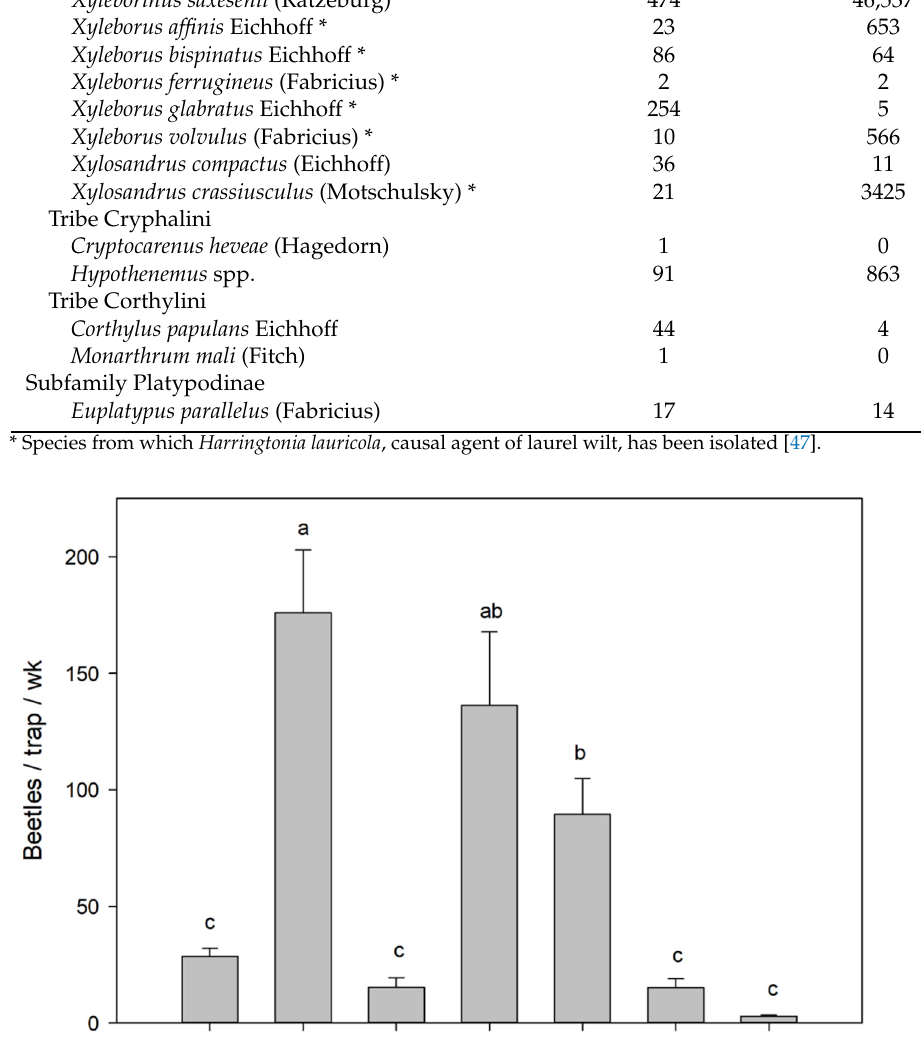
Figure 2. Mean ( ± SEM) captures of bark and ambrosia beetles (all species summed) in a 7-wk field test conducted in a swampbay forest with laurel wilt, Highlands County, Florida. Treatments contained α -copaene lures (cop), cubeb oil lures (cub), low-release ethanol lures (eth), combinations of essential oil lures and ethanol lures (cop + eth; cub + eth), bolts of silkbay ( Persea humilis ), and non-baited traps (control). Bars topped with the same letter are not significantly different (Tukey HSD mean separation, p < 0.05).